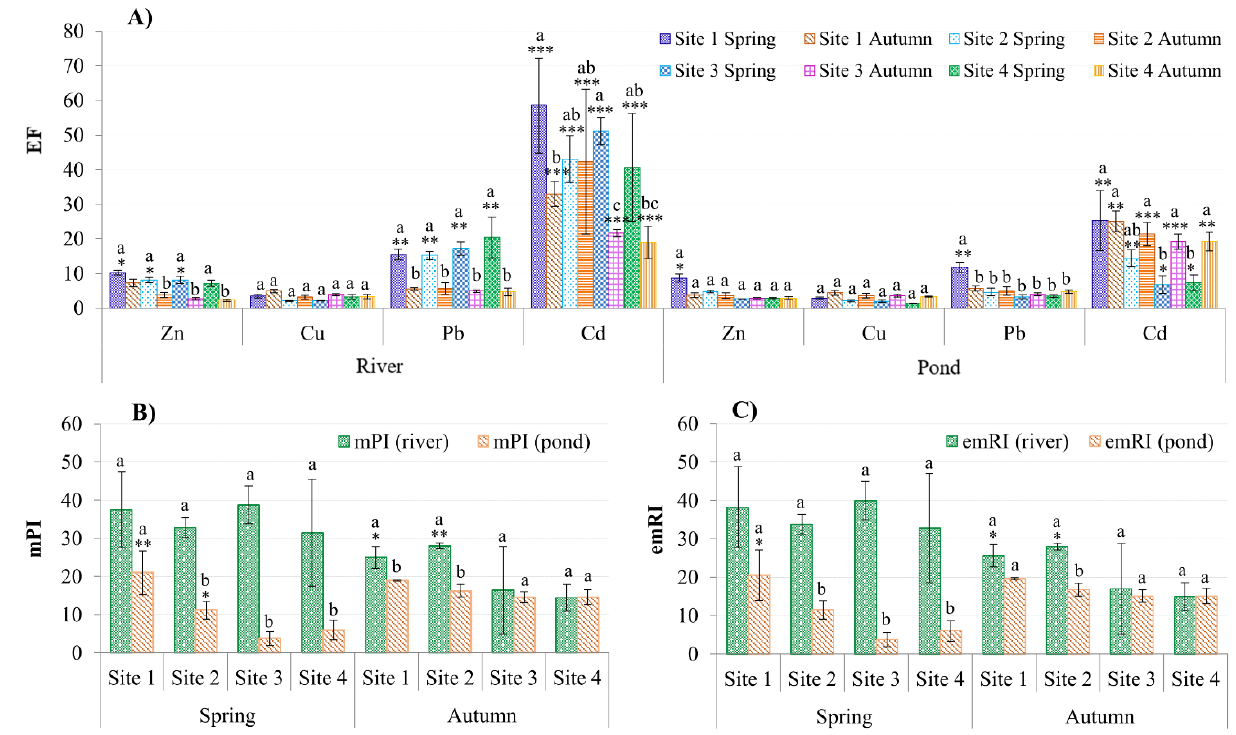
Figure 4. Ecological risk assessment for ( A ) single (enrichment factors) and ( B , C ) mixture of metals (mPI: modified Nemerow Pollution Index, and emRI: expanded, modified potential ecological risk index) in surface sediment from the Nhue-Day River basin. Asterisks (*) represent statistically significant differences between sites in each ecosystem ( A ) or in each season ( B , C ) when compared to the lowest value (mean ± SE, n = 3–12, * p < 0.05, ** p < 0.01, *** p < 0.001). Different letters (a > b > c) denote statistically significant differences between the site-season of each element ( A ) and between the ecosystems of each site ( B , C ) ( p < 0.05; ANOVA followed by the Tukey–Kramer test).